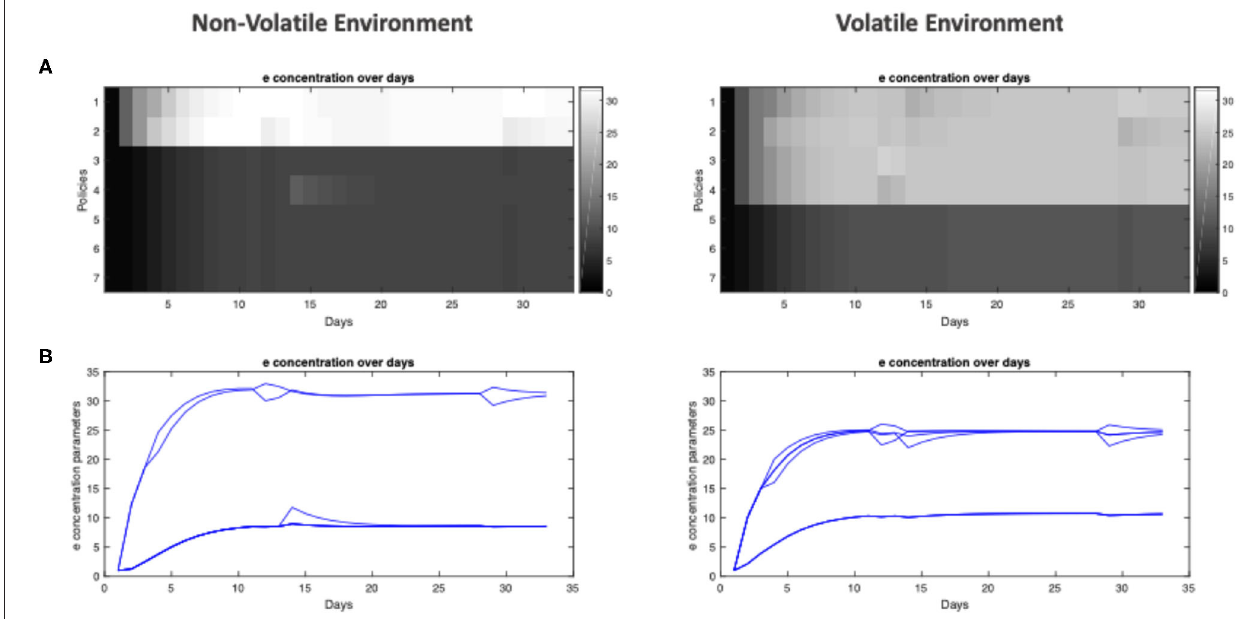
FIGURE 4 | Policy learning over days for agent training in non-volatile and volatile environments. (A) Heat-map of e concentration parameters for each policy (separated by rows) over all 32 days of training (separated by columns). (B) Plot of e concentration parameter for policies over 32 days of